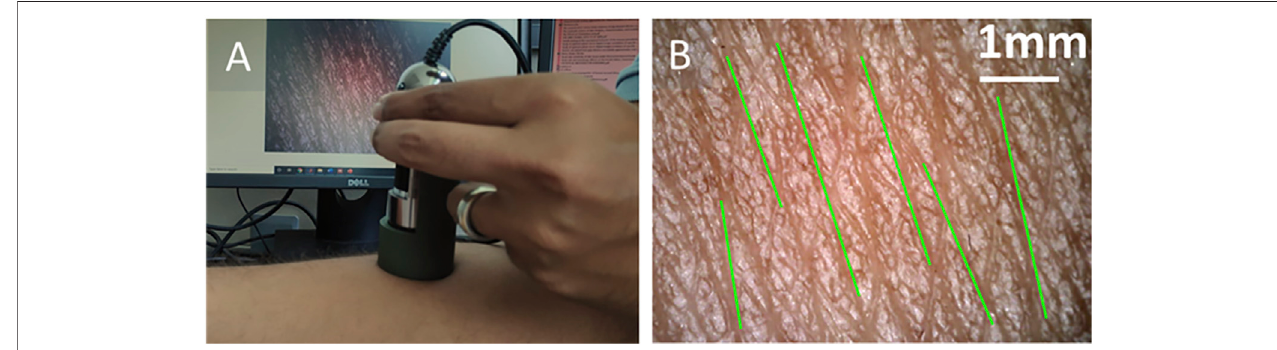
FIGURE 4 | (A) The hand-held microscope used to capture the magni fi ed image of the skin surface. (B) The captured image of the skin and identi fi ed orientation (green lines) of the wrinkle